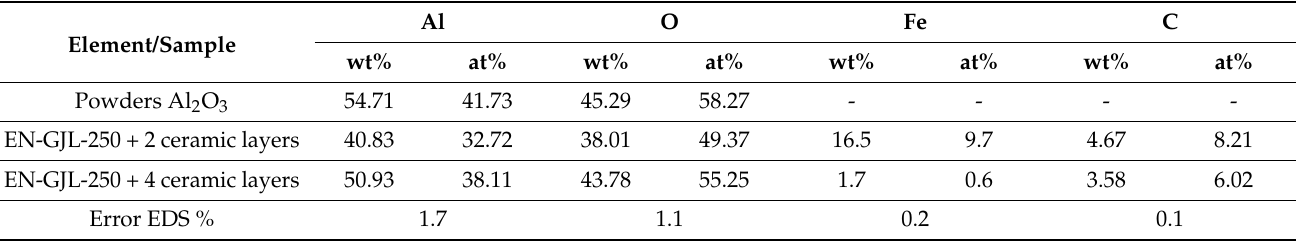
Table 1. Chemical composition of ceramic coatings deposited on cast iron